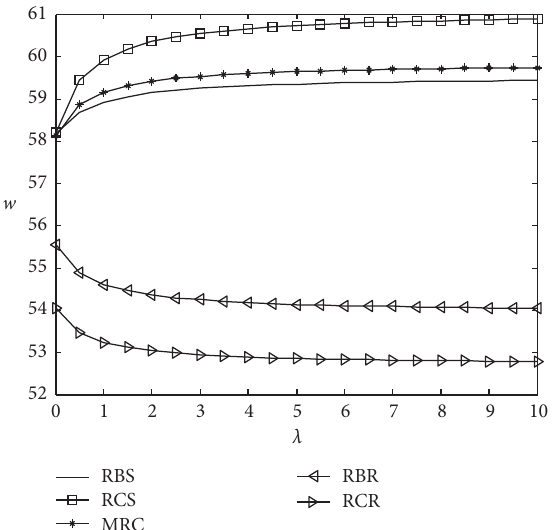
Figure 3: Effect of fairness preference coefficient on the wholesale price.